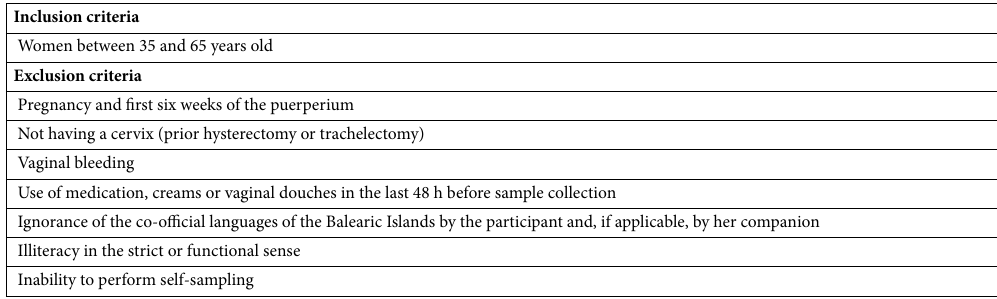
Table 1. Criteria for inclusion and exclusion in the